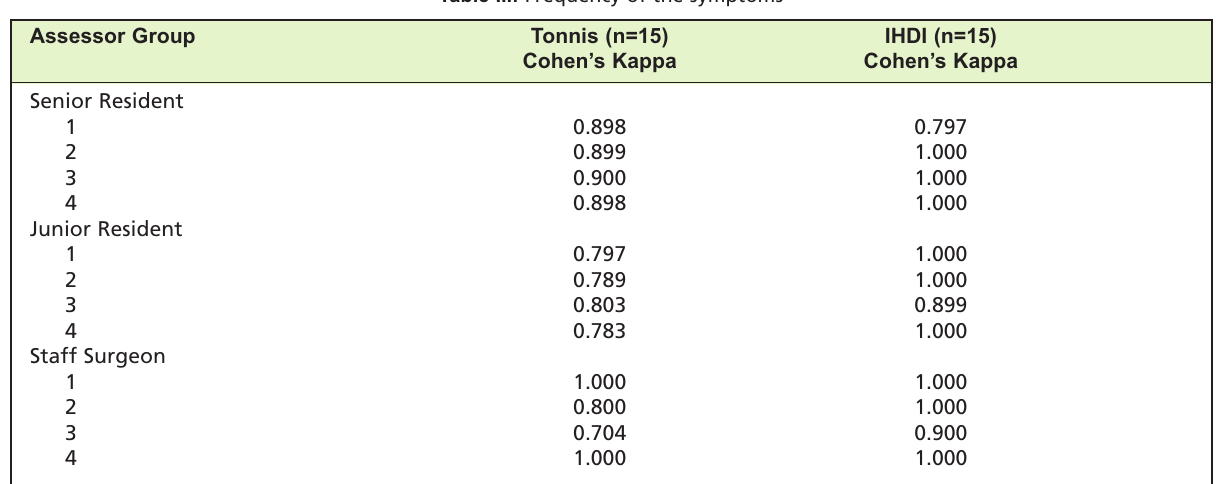
Frequency of the Table III: